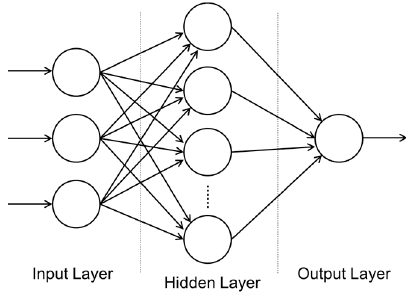
Figure 1. Schematic Diagram of Multilayer Feed-Forward Neural Network [21].